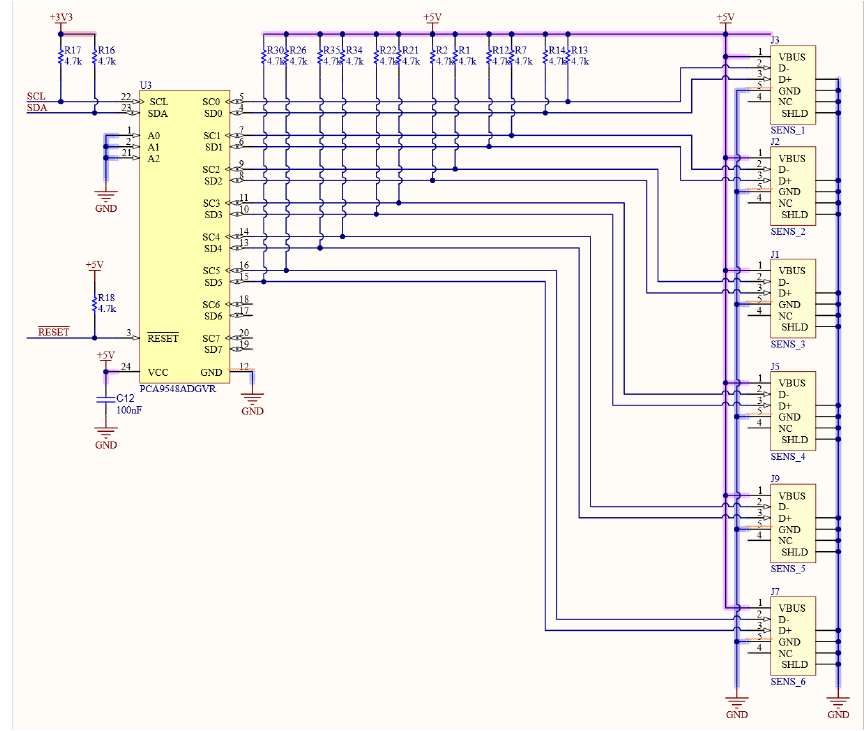
Figure 2. Sketch of connections of multiplexer used to cycle over sensors.